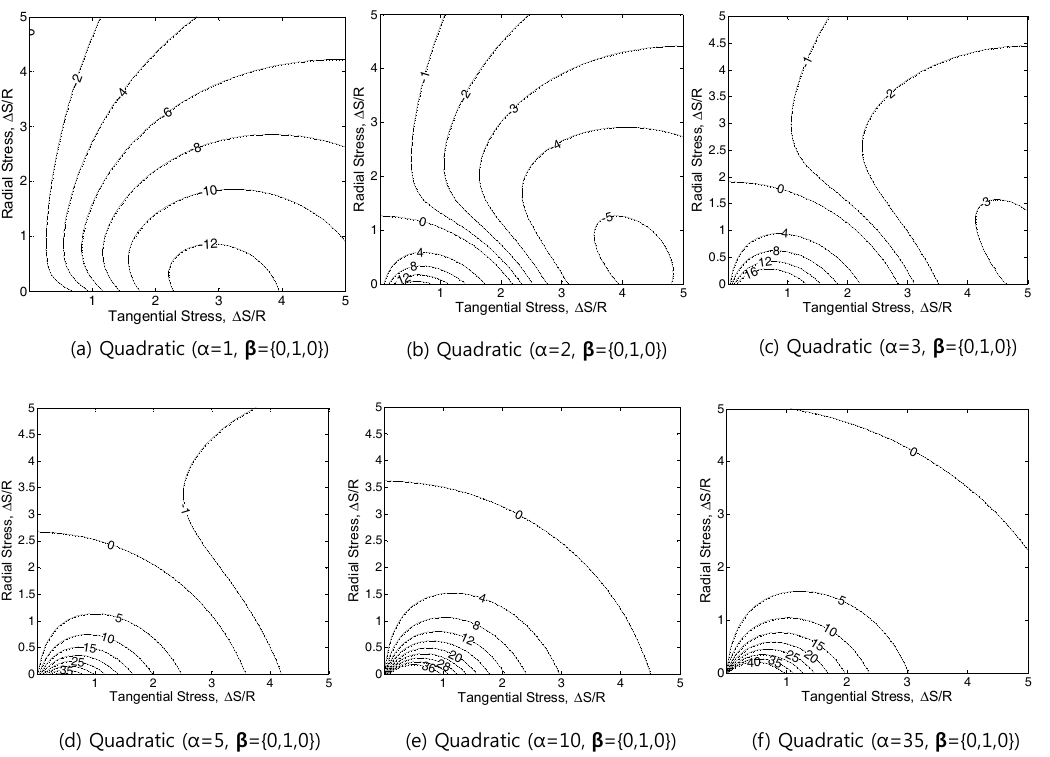
Figure 7. Quadratic generalized trapezoidal method in J 2 plasticity.